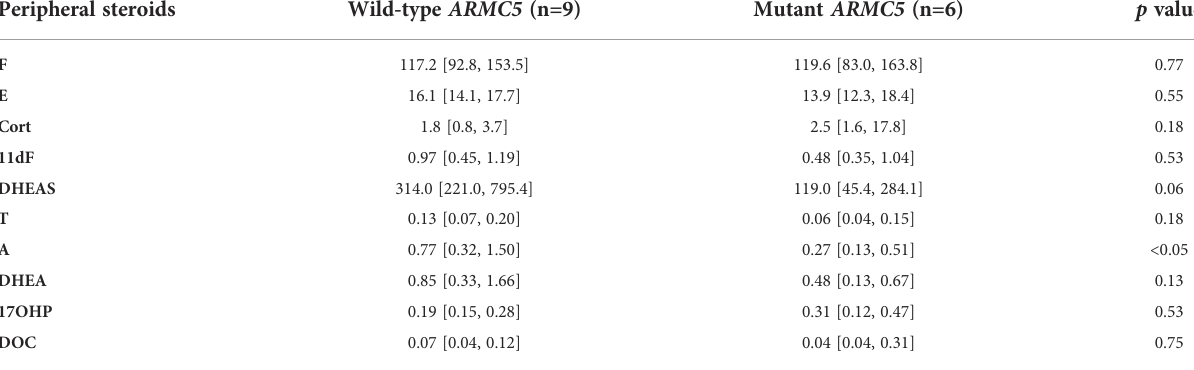
TABLE 1 Comparison of peripheral steroids (ng/ml) based on ARMC5